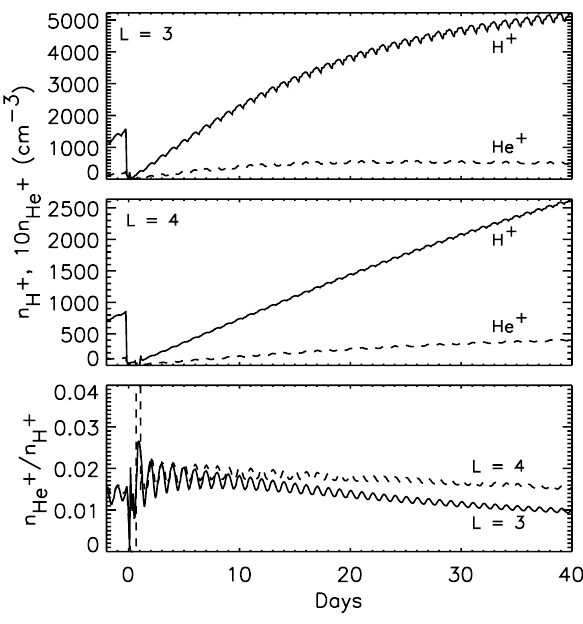
Fig. 1. H + and He + densities versus time following a model storm, with the He + density scaled up by a factor of 10, for longitude 0, winter, and moderate solar activity. Densities are given at the magnetic equator for L = 3 (top panel) and L = 4 (middle panel). He + /H + density ratios are also plotted (bottom